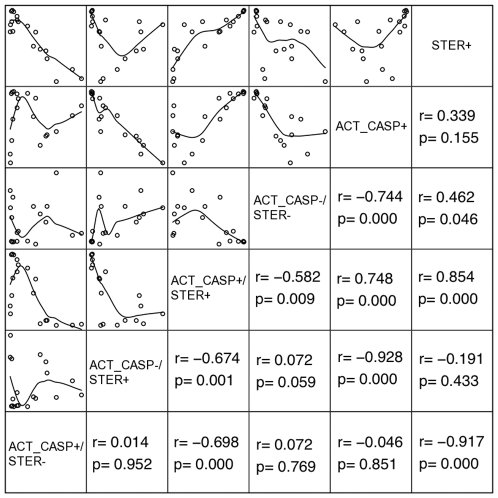
Correlations among distinct sperm subpopulations.Matrix of bivariate plots and Spearman correlation values among percentages of ejaculated sperm subpopulations expressing active caspase-3 and -7 and/or intracellular esterases obtained from flow cytometry analysis. Diagonal upper panel shows bivariate plots of different sperm subpopulations. Inner lines in bivariate plots indicate a general tendency of relation between points. Diagonal lower panel indicates Spearman r and p-value for each plot in a mirror form. Legends on diagonal: ACT_CASP+/STER−, percentage or sperm positives to active caspase-3 and -7 and negatives to cytoplasmic esterases; ACT_CASP−/STER+, percentage of sperm negatives to active caspase-3 and -7 and positives to cytoplamic esterases; ACT_CASP+/STER+, percentage of sperm positives to active caspase-3 and 7 and positives to cytoplasmic esterases; ACT_CASP−/STER−, percentage of sperm negatives to active caspase-3 and-7; ACT_CASP+, percentage total of sperm positives to active caspase-3 and -7 (ACT_CASP+/STER+ plus ACT_CAS+/STER−); STER+, percentage total of sperm positives to cytoplasmic esterases (ACT_CASP−/STER+ plus ACT_CASP+/STER+).